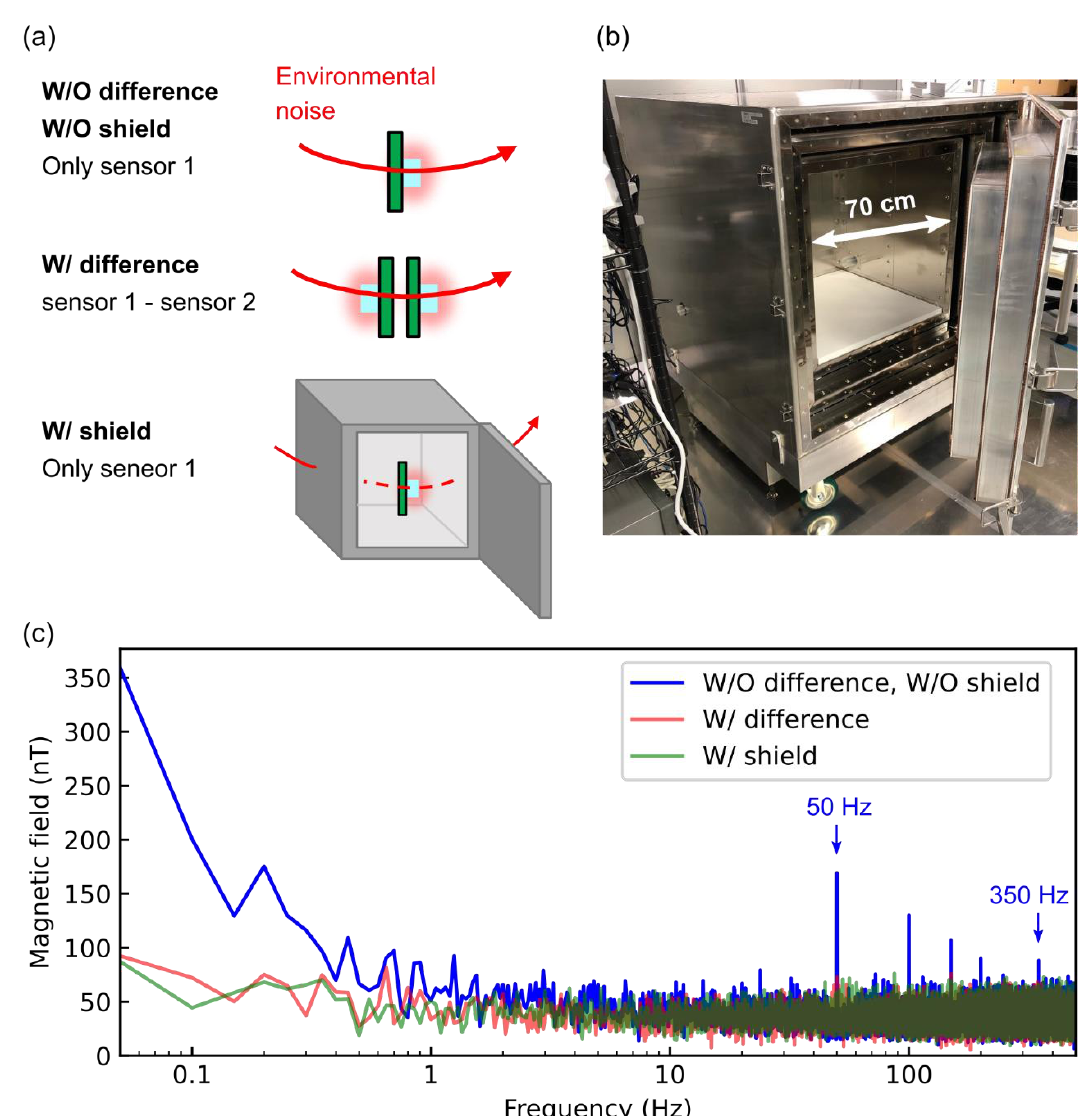
Figure 7. ( a ) Setup for measuring the magnetic noise frequency spectrum of the environment. (W/O difference, W/O shield) Only sensor 1 without any magnetic shielding nor using the gradiometer. (W/difference) The gradiometer with the base length of 50 mm. (W/ shield) Only sensor 1 in the three-layer magnetically shielded enclosure. ( b ) Three-layer magnetically shielded enclosure. The size of 70 cm is for magnetic sensing of small animals inside the enclosure. ( c ) Magnetic noise frequency spectrum. The peaks between 50 and 350 Hz are from the commercial power supply (50 Hz) and its harmonics. These magnetic noises propagated in space because the signal at 50 Hz and its harmonics disappear in a magnetically shielded enclosure (W/shield).